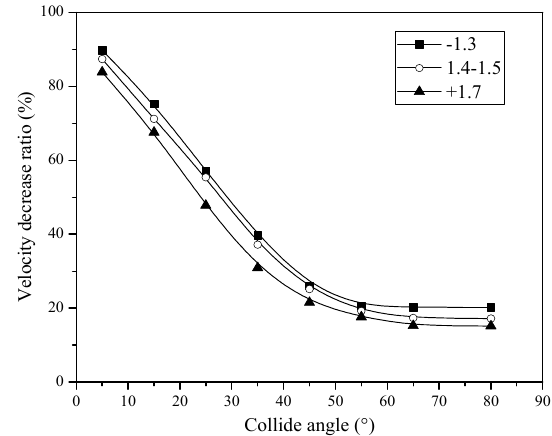
Figure 13. Reduction ratio of particle velocity at collision point.